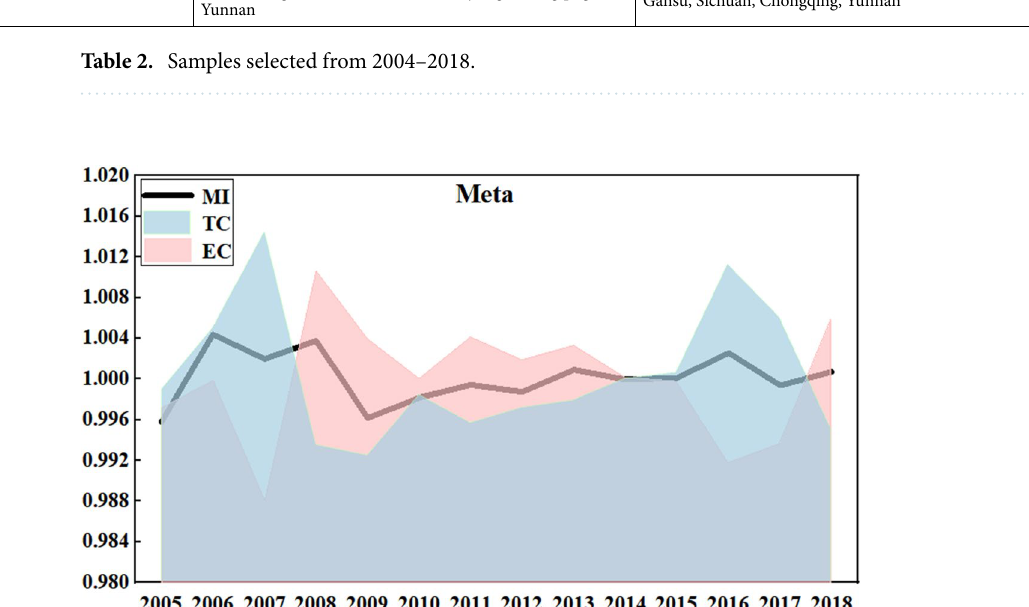
Figure 1. LHG and its decomposition index under meta-frontier from